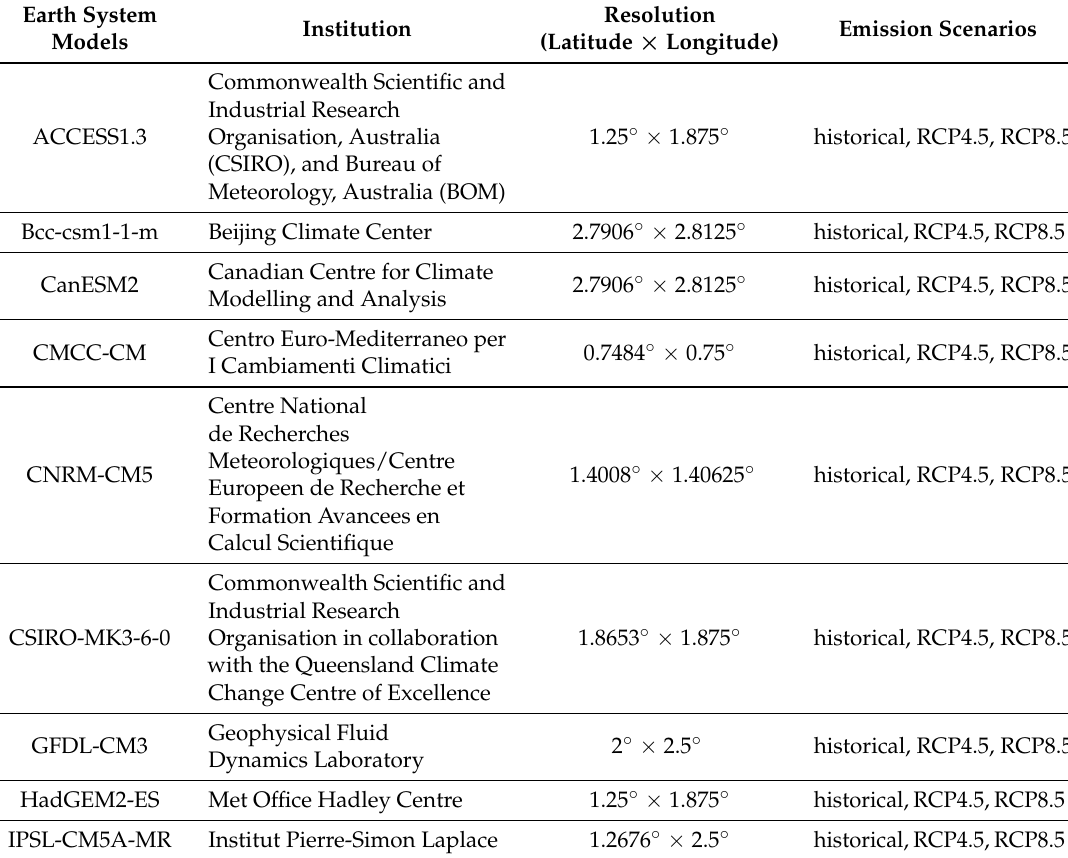
Table 1. Large-scale climate models used for future climate change scenario